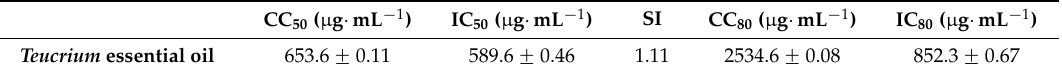
Table 3. Virucidal activity of T. pseudochamaepitys essential oil determined by the plaque reduction assay.